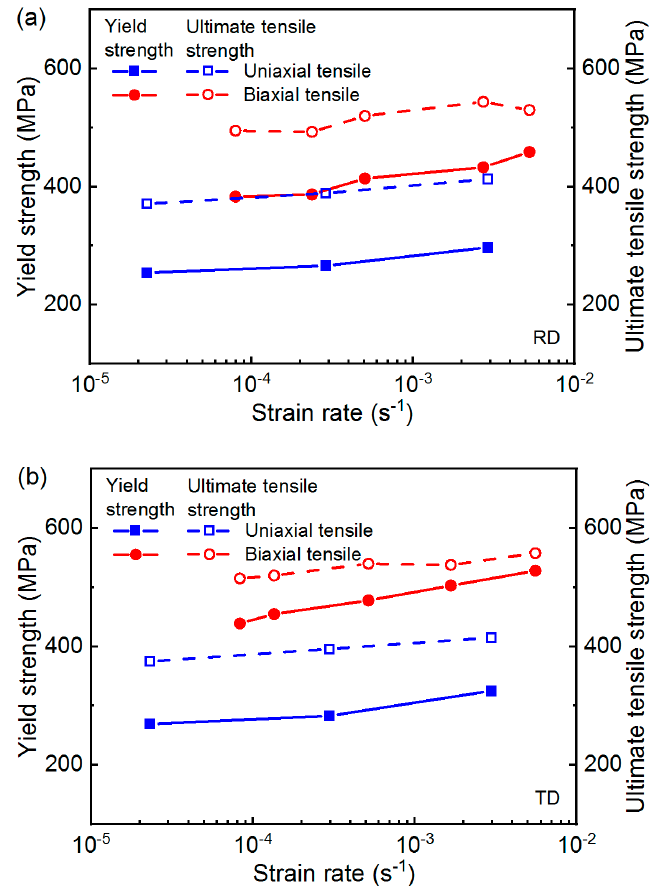
Figure 12. Variation of tensile strength with respect to strain rate: ( a ) tensile strength at RD, ( b ) tensile strength at TD.